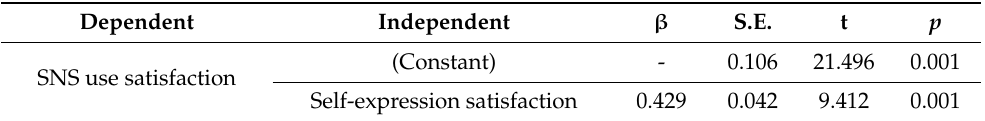
Table 8. Relation between self-expression satisfaction and SNS use satisfaction of Gen Z through